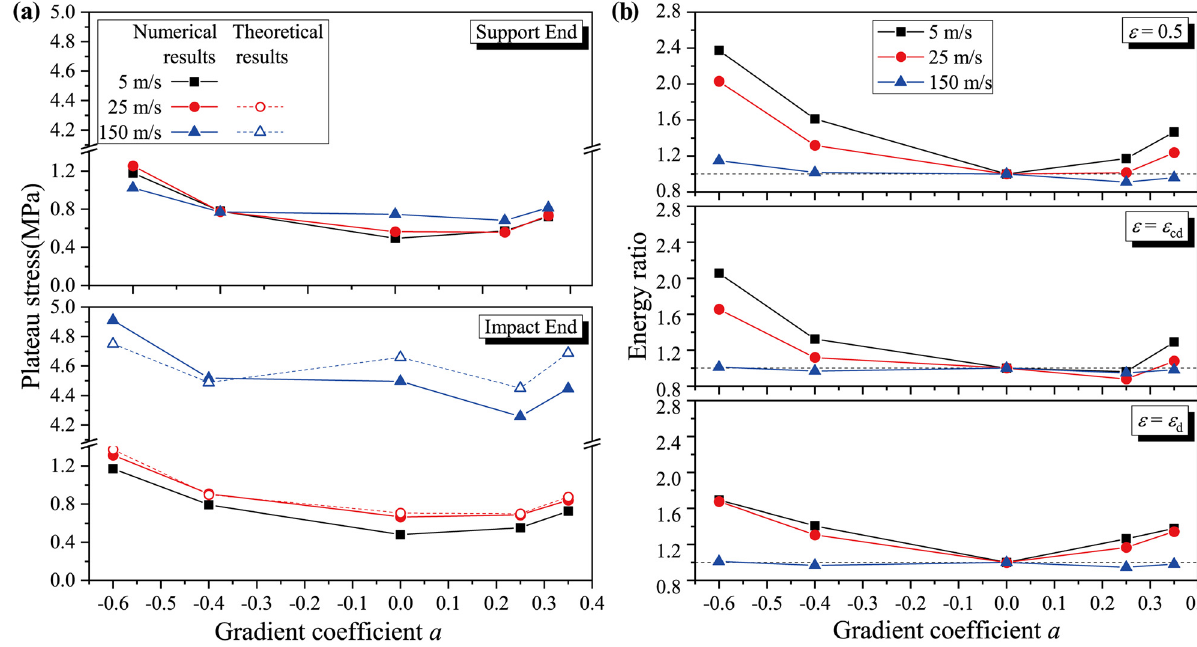
Figure 6: Curves of ( a ) the plateau stress and ( b ) energy ratio versus gradient coe ffi